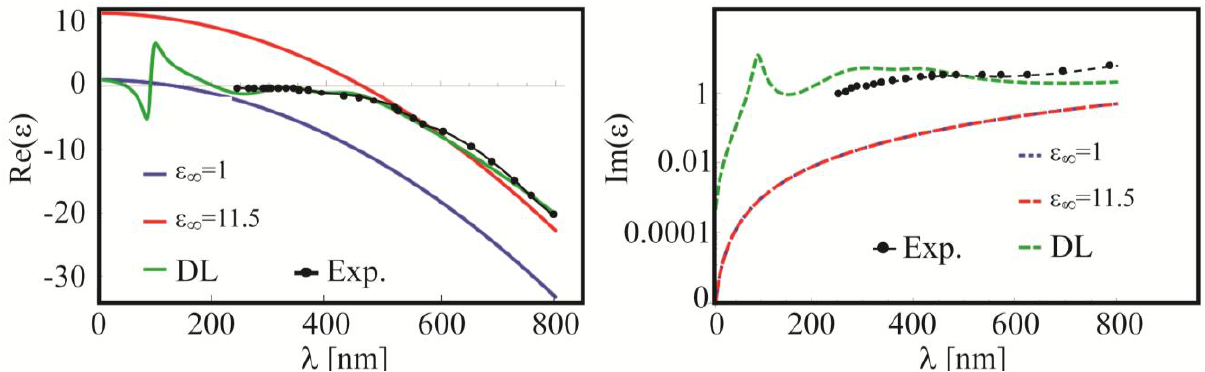
Figure 6. Real and imaginary part of gold permittivity. Comparison between Drude model with ε = 1 (blue lines), ε = 11.5 (red lines), Drude-Lorentz (DL, green lines) as proposed ∞ ∞ by Rakic in [50] and experimental data (black lines) from